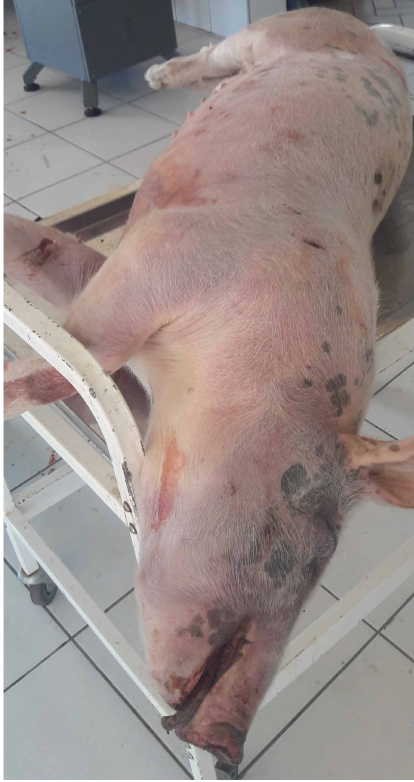
Figure 3: Carcass of a fattener showing large patches of skin hyperemia.